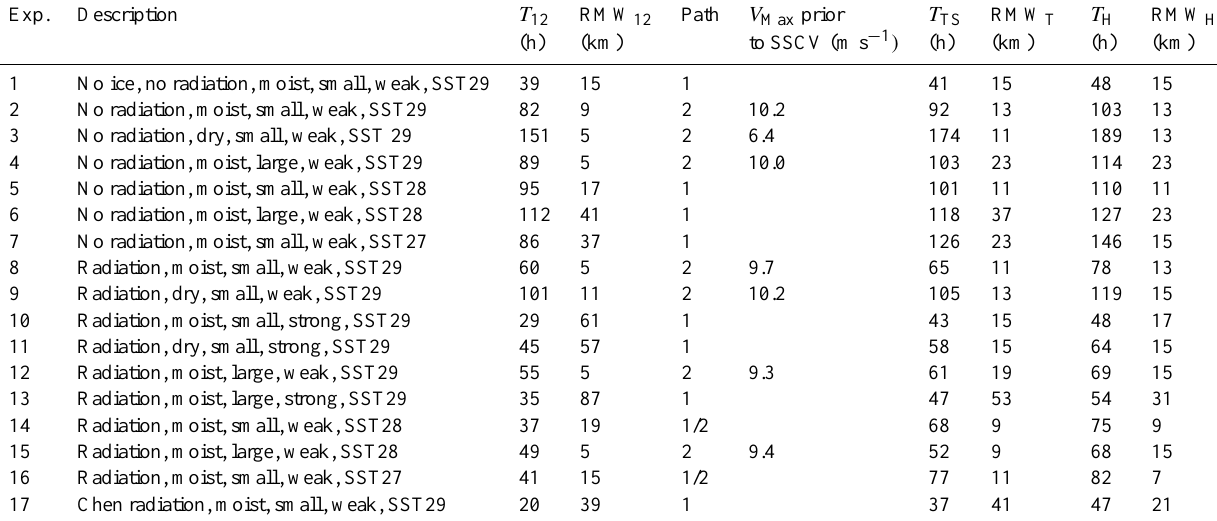
Table 2. General statistics for the experiments: shown are the time the maximum azimuthally averaged tangential wind speeds near the surface reach 12ms − 1 ; the near-surface radius of maximum winds (RMW) at this time; the pathway taken to genesis; the maximum near- surface tangential winds prior to the SSCV forming for systems that develop along pathway Two; the time at which the system becomes a tropical storm; the RMW at this time; the time the system becomes a hurricane; the RMW at this time.